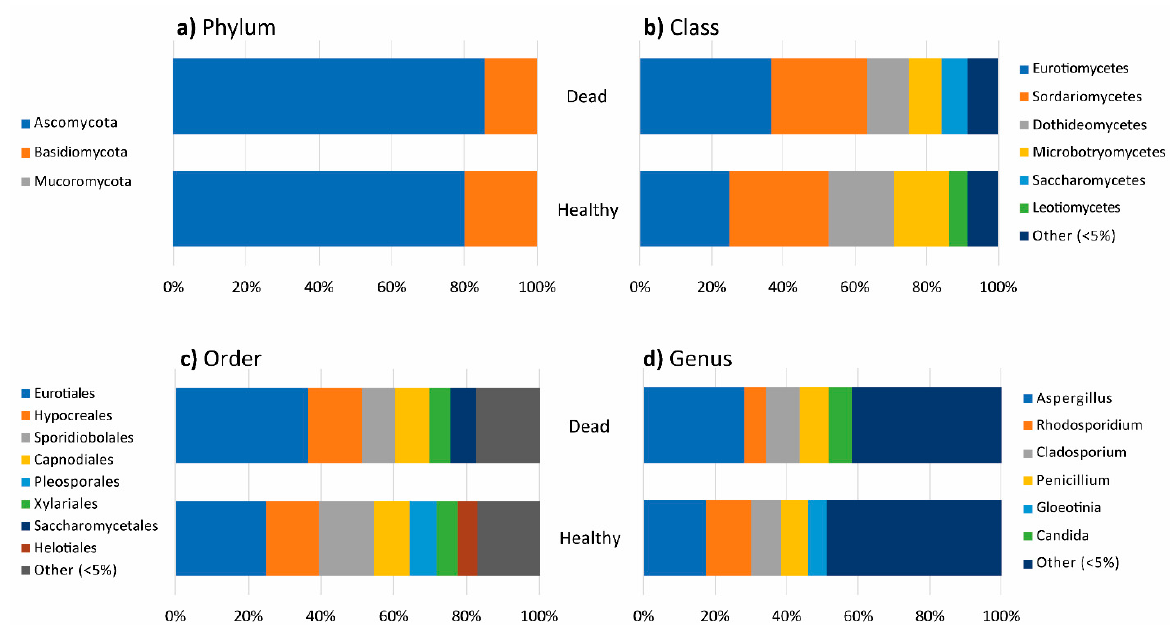
Figure 7. Bar chart showing diversity of fungi at ( a ) phylum, ( b ) class, ( c ) order, and ( d ) genus levels in healthy and dead thalli.